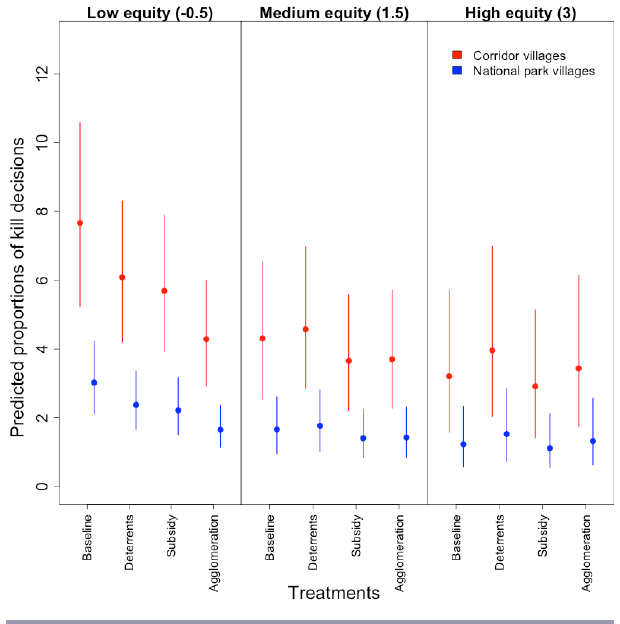
Fig. 5. Predicted proportions (%) of farmers’ decisions to kill elephants in the conservation and logging villages under three levels of equity. Predicted values computed from the reduced model (Table 2) are shown for the average household and group. Error bars are 0.95 quantiles of the bootstrapped distributions.